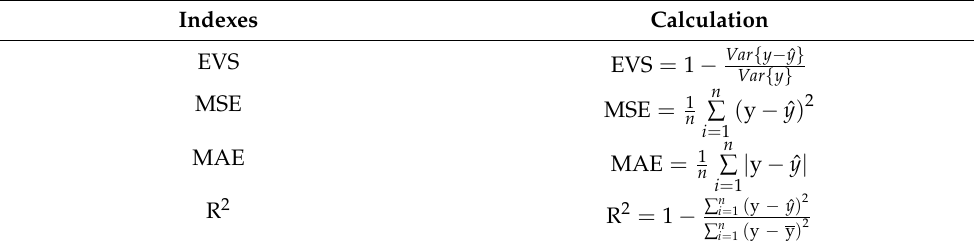
Table 1. Calculation Method of four